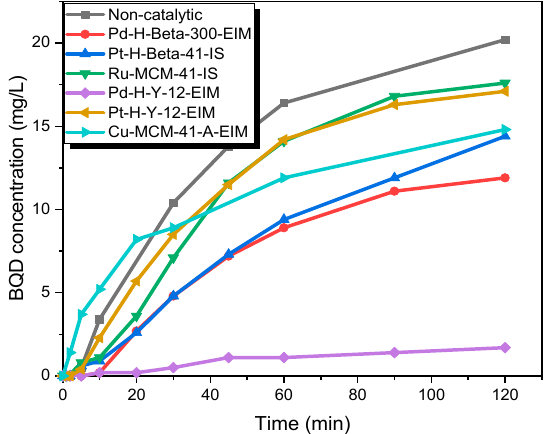
Figure 9. BQD concentration during the catalytic and non-catalytic ozonation of CBZ. C CBZ = 35 mg/L, gas flow rate = 110 mL/min, T = 20 °C, stirring speed = 900 rpm, C O3,g = 21 mg/L, C catalysts = 0.5 g/L.